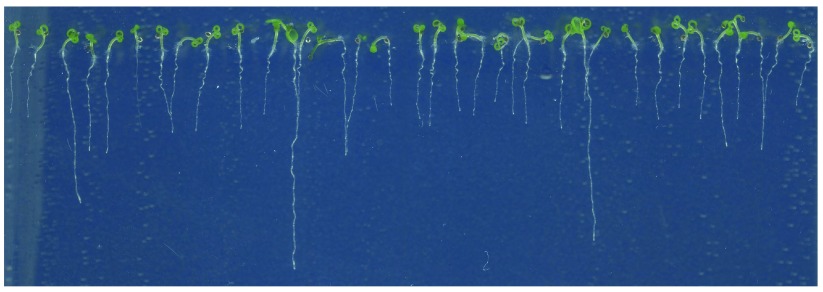
Restoration of the ethanol-inducible phenotype in the progeny of the F2 WT-looking plant from the cross
SS12K9 × abp1-c1 containing knock-down cassette and wild-type
ABP1 version.In the presence of 5% ethanol, F3 progeny show homogenous KD phenotype indicating that silencing of the construct might be responsible for wild-type phenotype of this plant in the F2 generation.